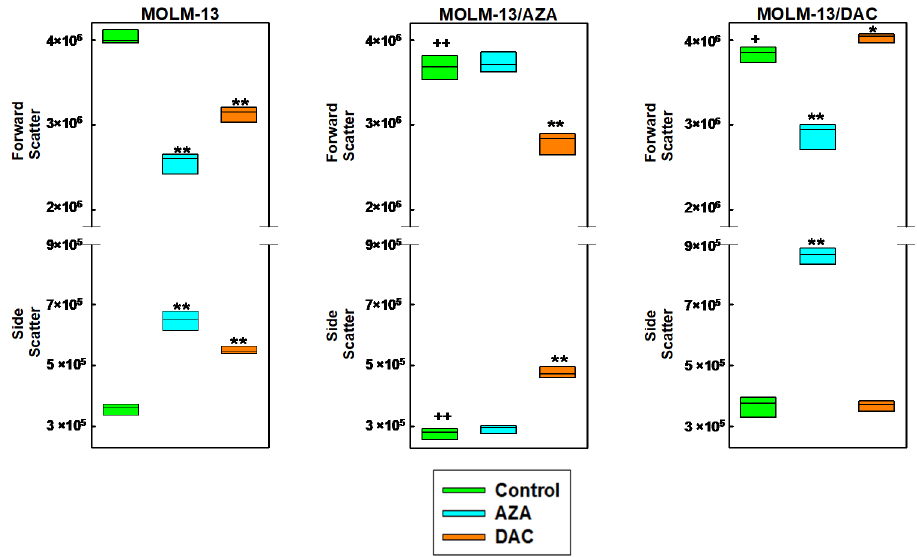
Figure 4. Box plots showing the forward and side scatter of MOLM-13, MOLM-13/DAC, and MOLM-13/AZA cells cultivated in the presence or absence of AZA or DAC (1 μM). The boxes were generated by SigmaPlot for Windows (Version 8.02, Systat Software GmbH, Erkrath, Germany) based on three independent measurements. Statistical significance: ++ and + = values differ from the data obtained for the MOLM-13 cells at the level of p <0.02 and p <0.05, respectively; ** and * = values differ from the data obtained for the respective cell types in the absence of AZA and DAC at the level p <0.01 and p <0.02, respectively. The top and bottom of each box represent the 5th and 95th percentiles, respectively, and the horizontal line in the box represents the median value.